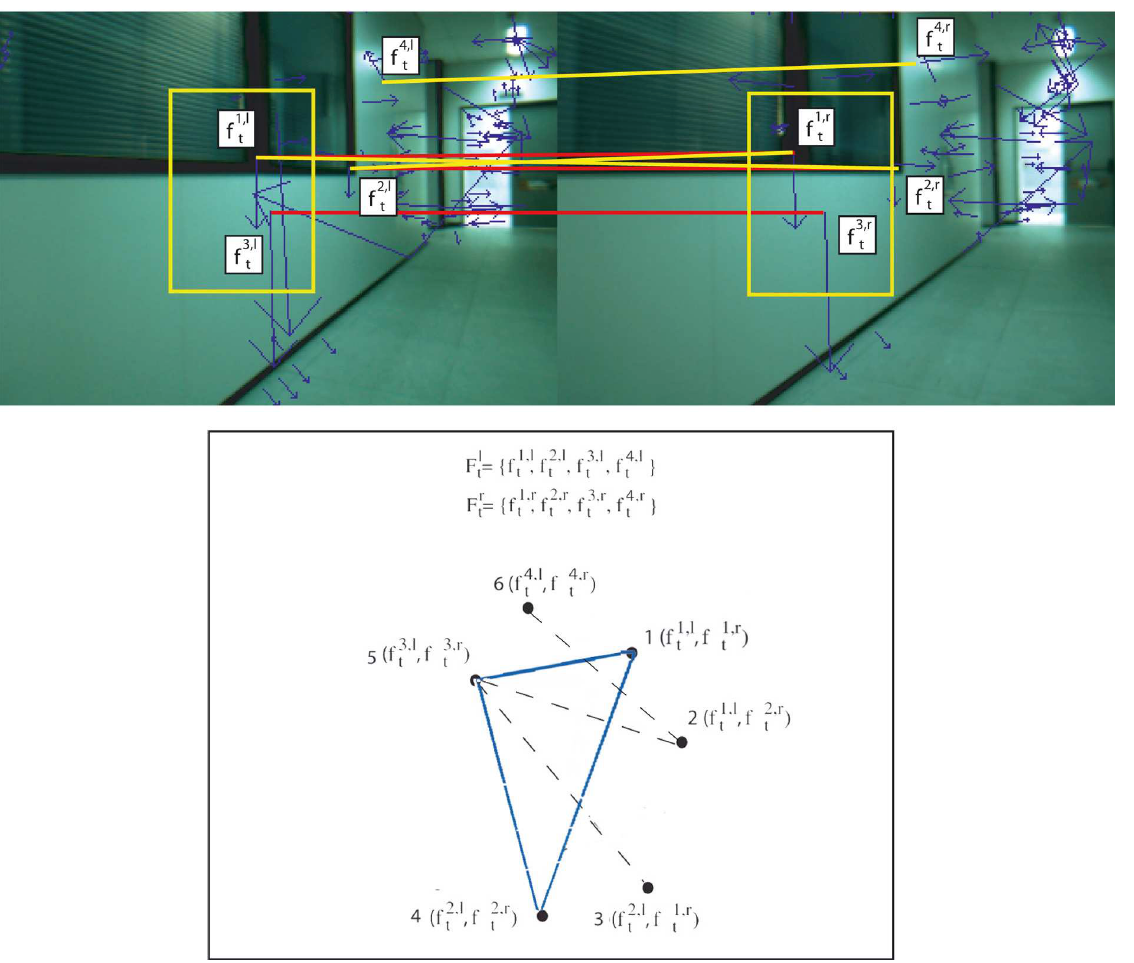
Figure 4. Vertices represent tentative matchings when considered individually. Arcs indicate compatible associations, and a clique is a set of mutually consistent associations (e.g., the clique { 1 , 5 , 4 } implies that associations f 1 ,l may